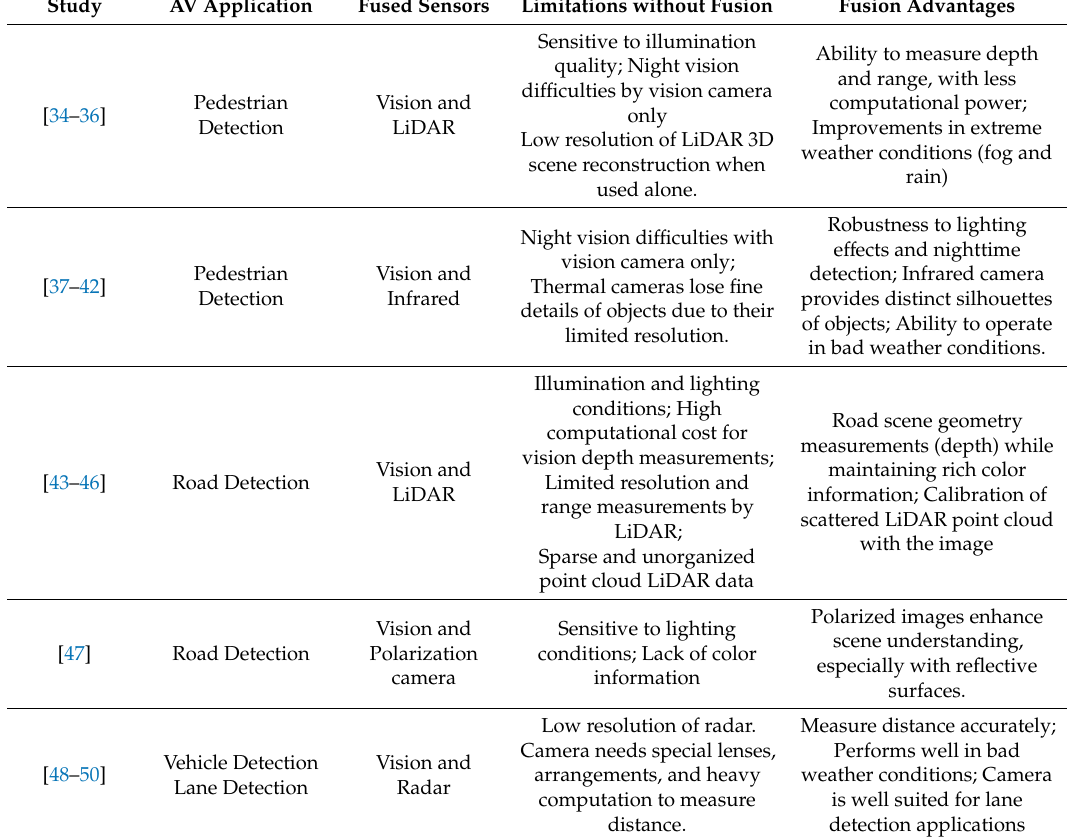
Table 1. Summary of AV applications, limitations of sensors, and advantages of sensor